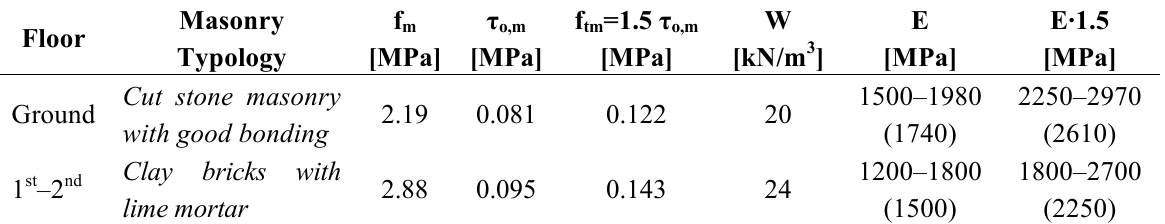
Table 1. Mechanical properties of masonry estimated for ‘Palazzo